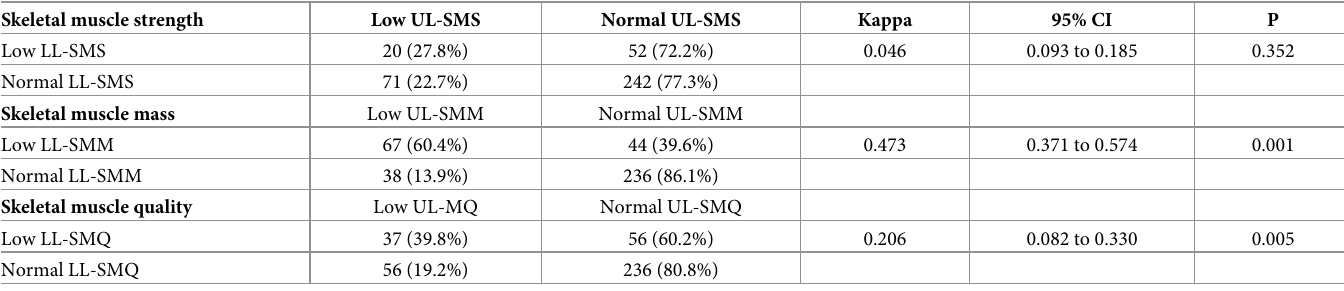
Table 3. Agreement between upper and lower limb measures to identify older adults with low skeletal muscle strength, muscle mass and muscle quality.